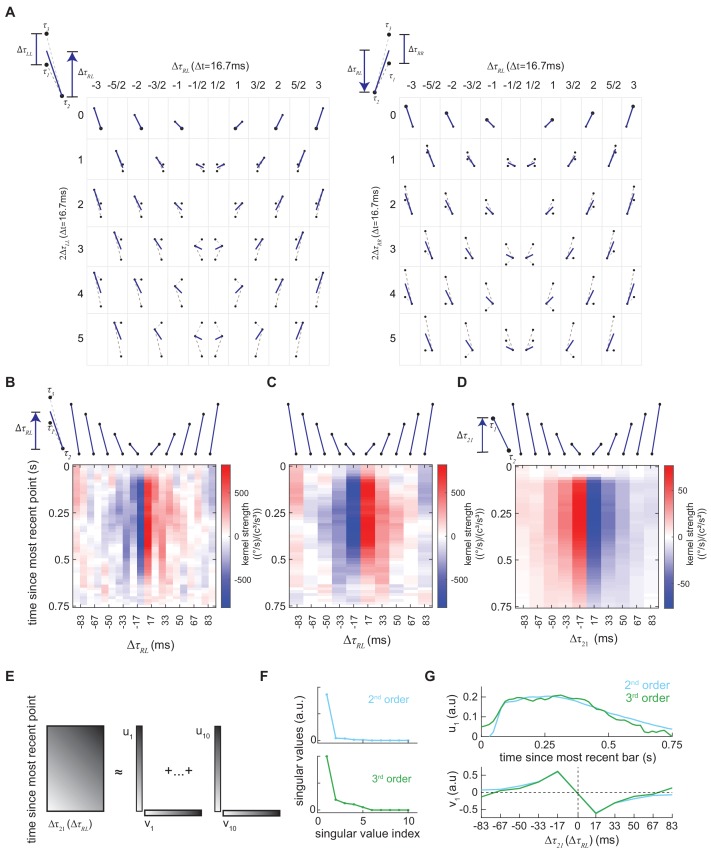
Rearranging the second- and third-order kernels and computing singular value decompositions on the rearranged kernels.(A) Diagrams to demonstrate how the third-order kernel was rearranged. The 'ball-stick' diagram represents the spatiotemporal structure of the triplet correlations. Left:
ΔτLR is the average time difference between the left points and the right point, and 2ΔτLL is the temporal separation between two left points. In the grid, the rows represent 2ΔτLL in the unit of frame Δt=16.7 ms, and the columns represent -ΔτLR. In the first row, the temporal distance between two left points is zero, so two left points overlap with each other, which is represented by a solid dot surrounded by an empty circle. The z-axis, which is not shown here, represents times since the most recent point. Right: Similar to left panel, but in this case, there are two points on the right and one point on the left. In the grid, the rows represent 2ΔτRR, and the columns represent ΔτRL=-ΔτLR. Positive ΔτRL means the left point is more recent than the right points (Materials and methods). (B) Two-dimensional representation of the third-order kernel by summing the rearranged third-order kernel elements in (A) and (B) over ΔτRR and ΔτLL (Materials and methods). In this new format, rows represent time since the most recent point, and columns describe the temporal distance between right and left points, with negative intervals meaning that the right point is more recent than the left point. (C) Two-dimensional representation of the third-order kernel created by summing neighboring columns in (B). (D) Second-order kernel visualized using an impulse-response format (Materials and methods). Top: the ball-stick diagrams represent the relative spatiotemporal structure of the pairwise spatiotemporal correlations. Bottom: the color map denotes the 'impulse response' to the corresponding pairs, and the color represents the kernel strength, the columns represent Δτ21, and the rows represent the time since the most recent point in the pair. (E) Diagram of the singular value decomposition of a matrix. The matrix can be approximated by a series of outer products of vectors. (F) The singular values of the second-order kernel (blue) and the third-order kernel (green). (G) The optomotor turning response of the fly can be modeled as a correlation-sensitive module that represents motion computation and a low-pass filter module that represents the dynamical change of the turning behavior (Clark et al., 2011). The left vector (top) could be interpreted as the dynamics in a behavioral module and the right vector (bottom) as a correlation-sensitivity module.